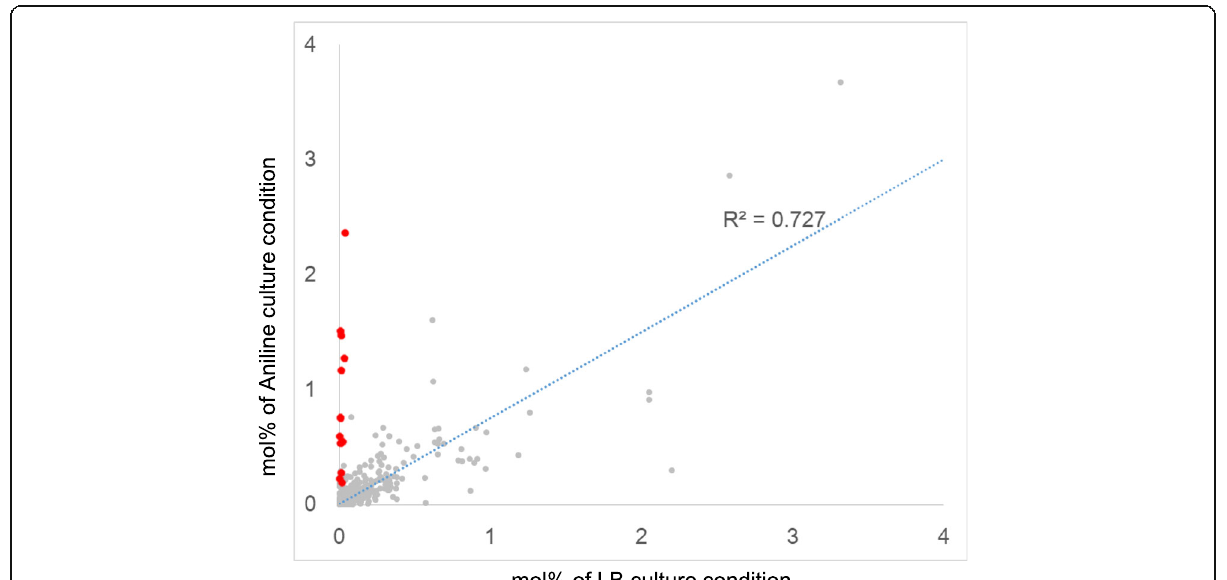
Fig. 3 Correlation of two proteome sets of Delftia sp. K82. The two proteome sets are highly correlated ( R 2 : 0.727) when aniline degradation cluster proteins are excluded. Red dots indicate aniline-degrading cluster proteins. However, when aniline degradation-related proteins are included, r squared value of two proteome sets was decreased to